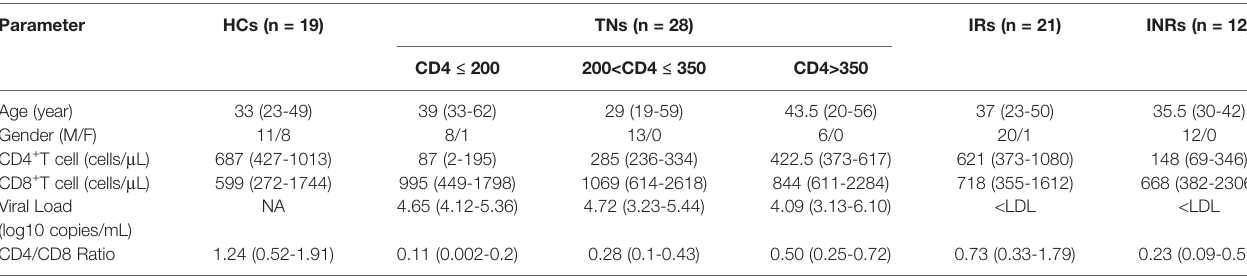
TABLE 1 | Baseline characteristics of the enrolled participants.